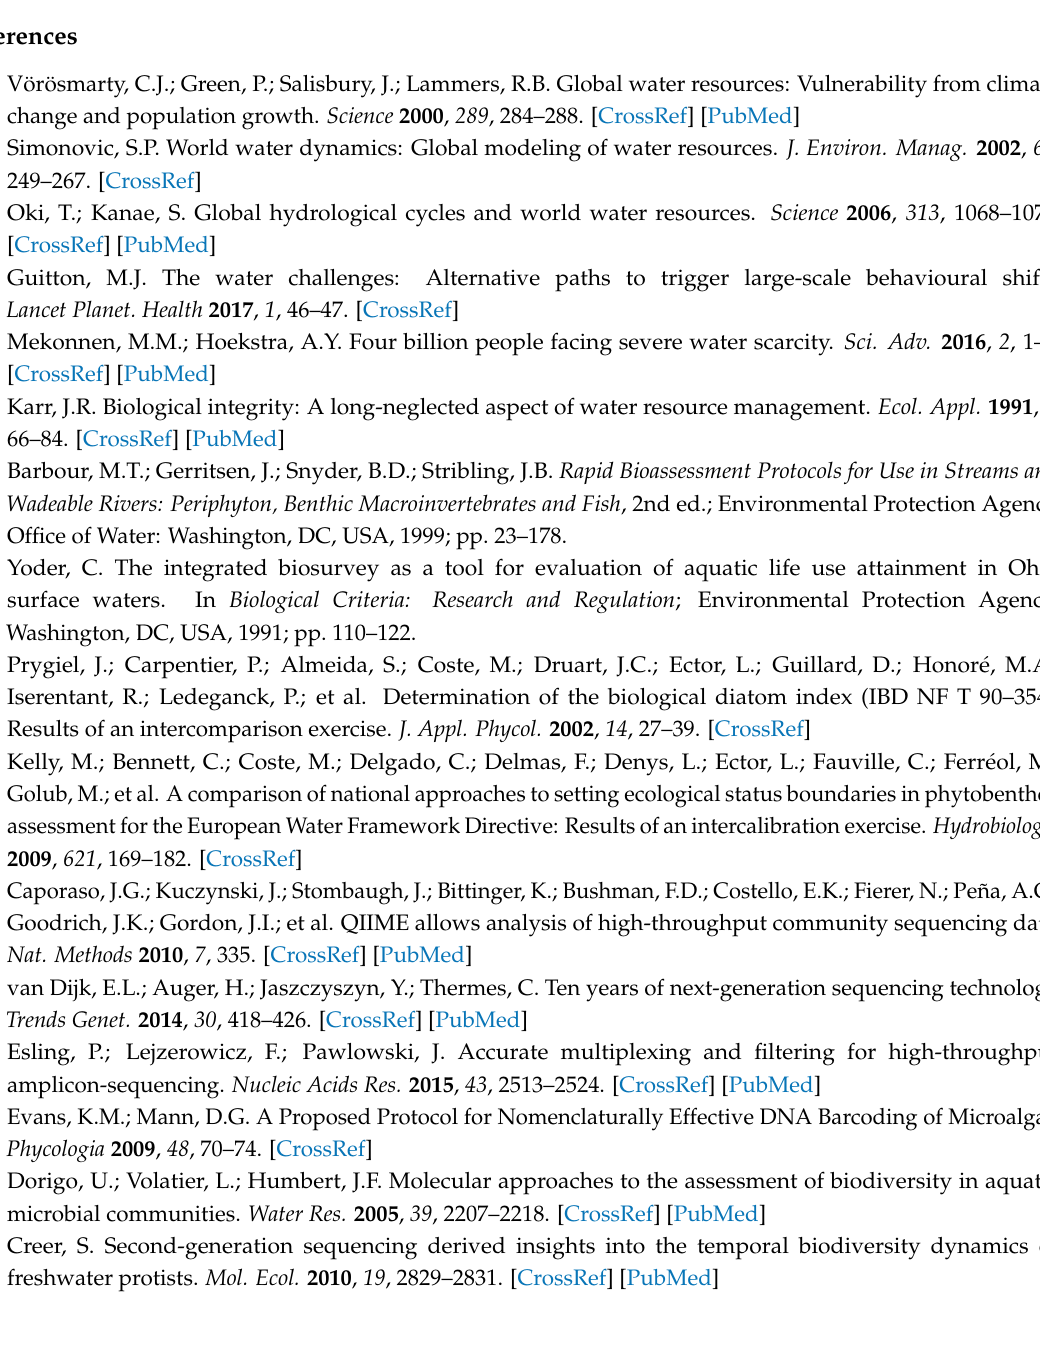
Figure A2. Relative abundance (%) of taxa and OTUs of phytoplankton using traditional optical microscopy method (TOM) and high throughput sequencing method (HTS). OTUs percentage was only that the number of OTUs of one assemblages accounted for the total OTUs number of phytoplankton identified from the 16S and 18S sequencing datasets.